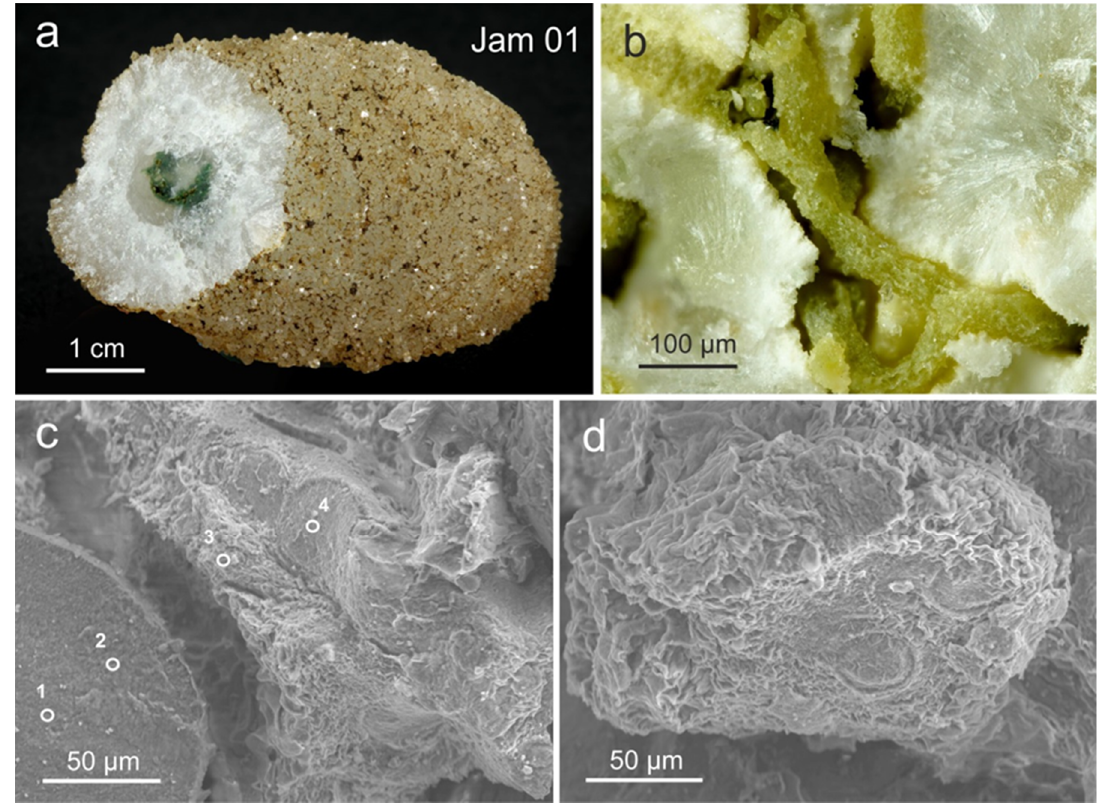
Figure 16. Images of sample Jam 01 (Jamner): ( a ) elongated SiO 2 aggregate inheriting an olive-green filamentous core; ( b ) details of the green filamentous core of the silica aggregates; ( c ) SEM micrograph of a dense filamentous core without recognizable texture surrounded by an empty space and the following mineralization sequence; the numbers relate to local chemical analyses by SEM-EDX (see Table S5); ( d ) mineralized matrix consisting of irregular masses with a rough surface texture missing visible crystals.